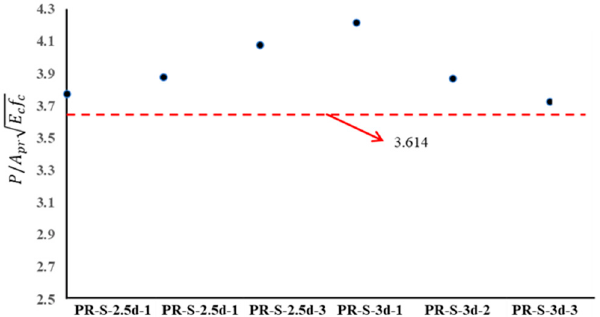
Figure 11. Comparison between predicted ultimate strength and experimental results.